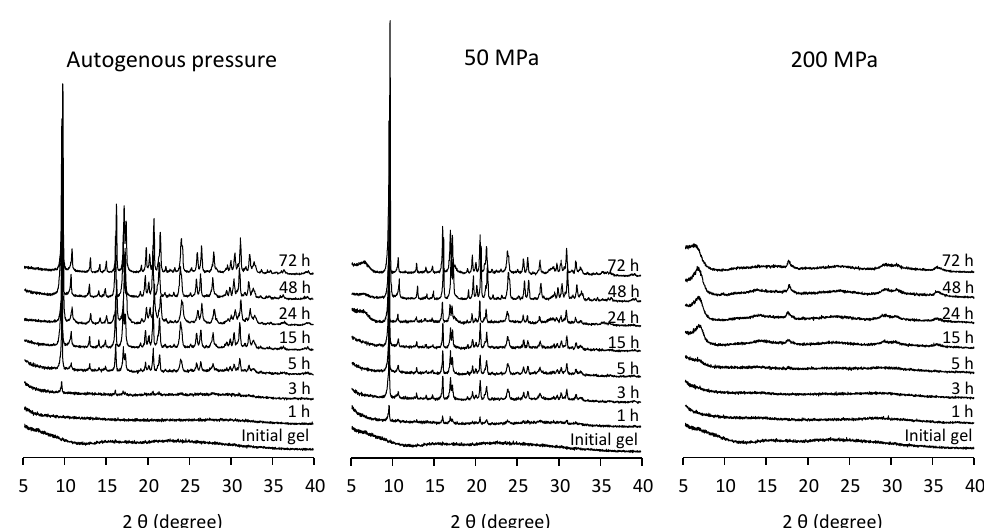
Figure 1. XRD patterns of the obtained solids under autogenous pressure, 50 MPa and 200 MPa at 150 °C for 1 to 72 h using the diluted synthesis mixture (H 2 O/Al 2 O 3 = 50). SEM images of the solids obtained after 24 h of synthesis are shown in Figure 2. The pure SAPO-18 phase prepared under AP and 50 MPa shows the characteristic cubic crystals. The hydrostatic pressure increase enlarged the crystal size of the SAPO-18 as previously reported for the MFI zeolite [23]. On the other hand, the unknown phase obtained under 200 MPa shows long rod-type layered crystals. Figure S2 shows the SEM images of the solids obtained under AP and 200 MPa at different synthesis times. Cubic crystals started to be observed after 3 h of synthesis under AP and, the crystals continued growing by consuming the initial amorphous solid. On the contrary, all the solids obtained under 200 MPa show amorphous particles similar to those observed in the initial amorphous solid, while the unknown layered crystals start to appear after 5 h of heating, being clearly visible after 15 h.